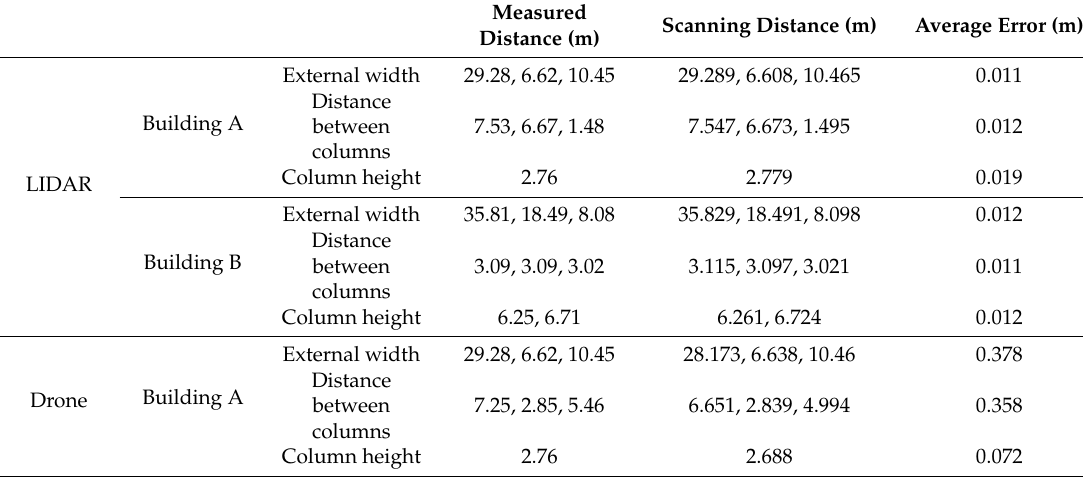
Table 2. Errors of LIDAR / drone-based point cloud data.